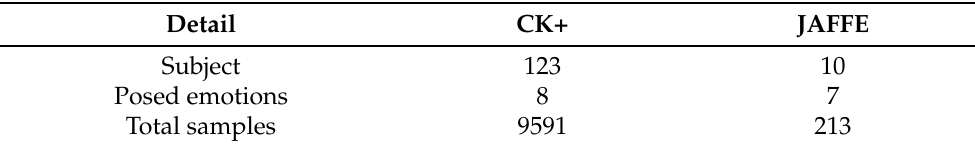
Table 2. Number of subjects and number of emotions in each database.